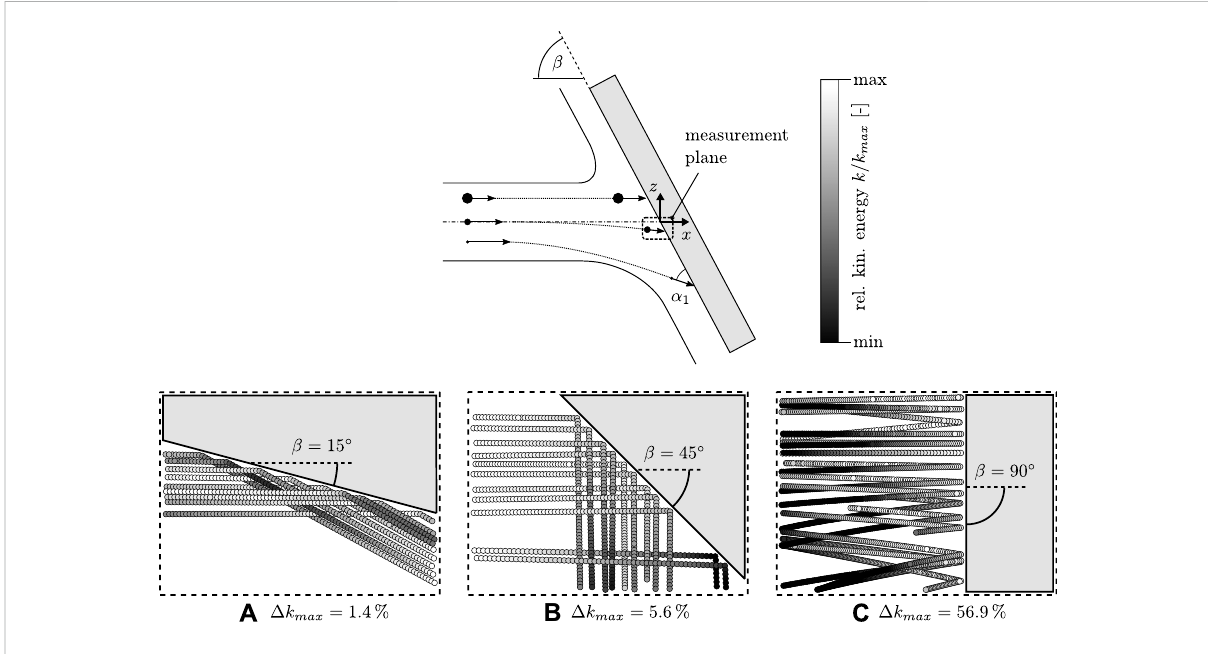
FIGURE 10 Deviation of the particle ’ s kinetic energy within the measurement plane for the numerical simulation.